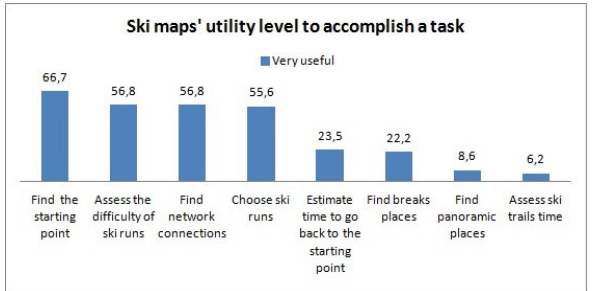
Figure 11. Percent of response “very useful” ski map when making a task in a ski resort.